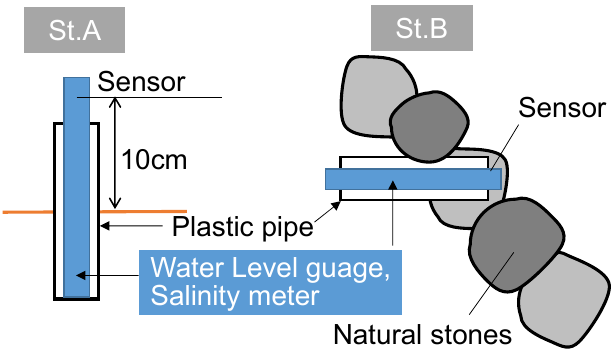
Figure 5. Installation of salinity meters and water level guages. The upper chart of Figure 6 plots the Akigase Weir (35 km) discharge and tidal level recorded at the Harumi Observatory (Tokyo Bay), the middle chart plots the salinity at Urayasu (Tokyo Bay), and the lower chart plots the salinity measured at the Nishiarai Observatory (13 km) and St. B (12 km). The salinity was higher at St. B than in the upper layer measured at the Nishiarai Observatory. From this year-round observation data, we see that the salinity remains significantly lower from late April to early October, compared with the rest of the year. This seasonal drop in salinity is thought to result from the dilution of the salinity of Tokyo Bay by the river water inflow during the flood season.